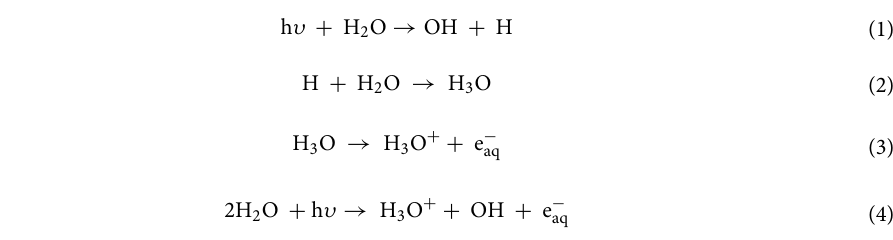
Figure 7. 3D structures of the heaviest TSP-derived chemical